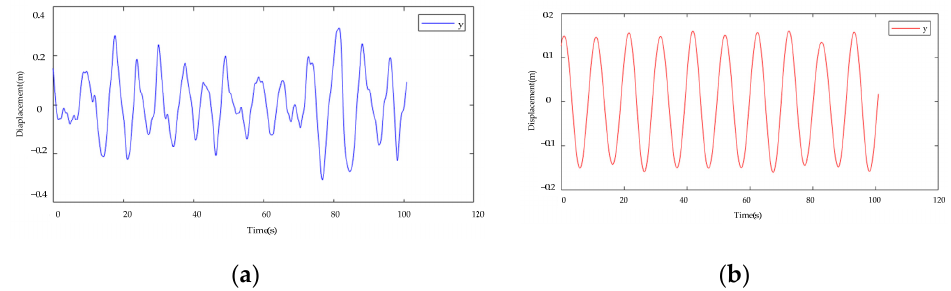
Figure 12. Different integration techniques’ data curves. ( a ) Double Integral Curve in Time Domain; ( b ) Time-frequency domain hybrid integration curve. ( b ) Time-frequency domain hybrid integration curve.